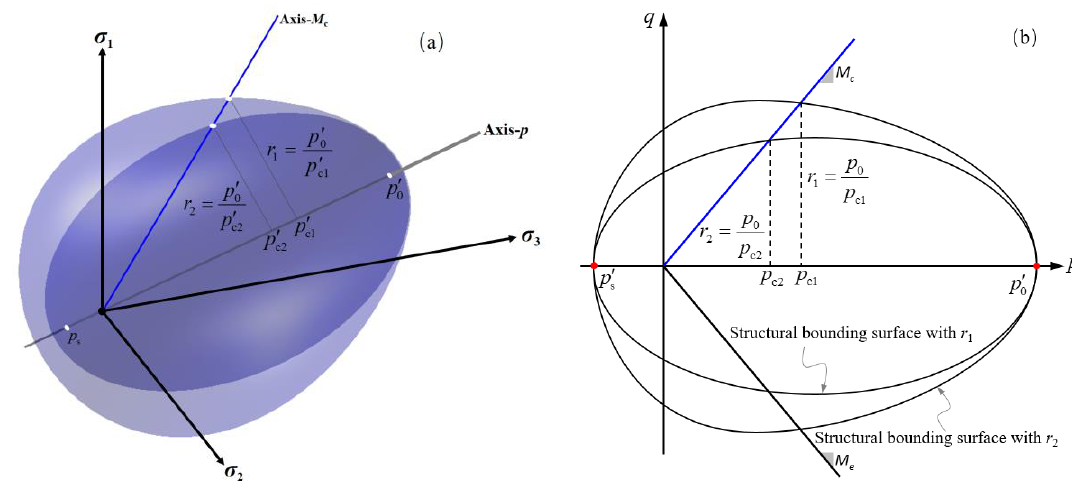
q plane. Figure 2. Bounding surface in ( a ) principal stress space and ( b ) p (cid:48) - q